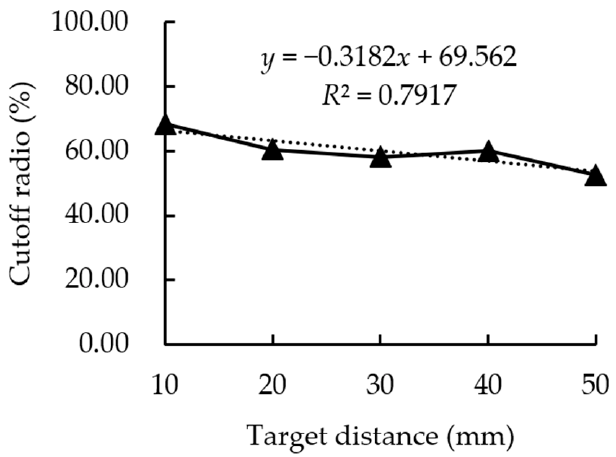
Figure 7. In fl uence of the target distance on the cuto ff ratio. Figure 7. Influence of the target distance on the cutoff ratio.